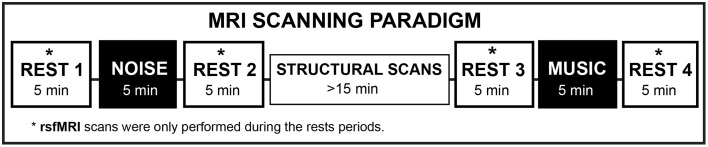
Experimental rsfMRI paradigm. The washout condition was executed during the “Structural Scans” period. NOISE, Control condition (pink noise). rsfMRI, resting state functional magnetic resonance imaging.